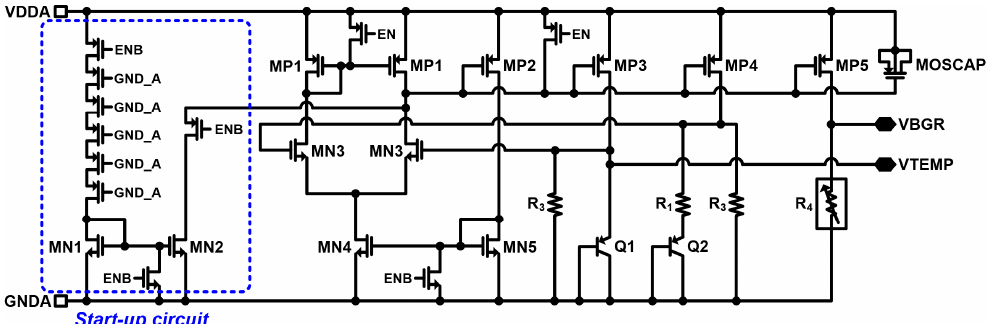
Figure 7. Schematic of bandgap reference of the fully integrated temperature sensor.